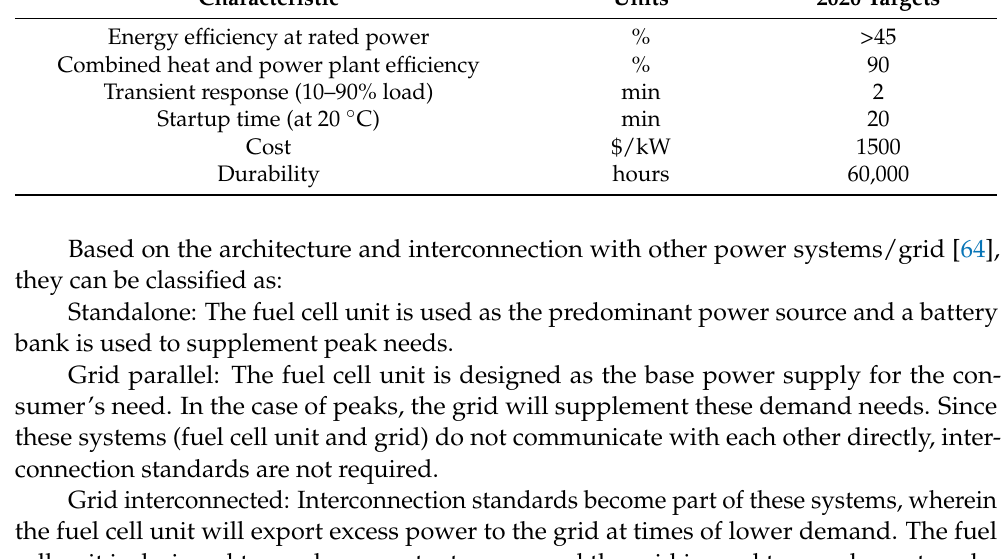
Table 7. DOE targets for stationary applications. Characteristic Units 2020 Targets Energy efficiency at rated